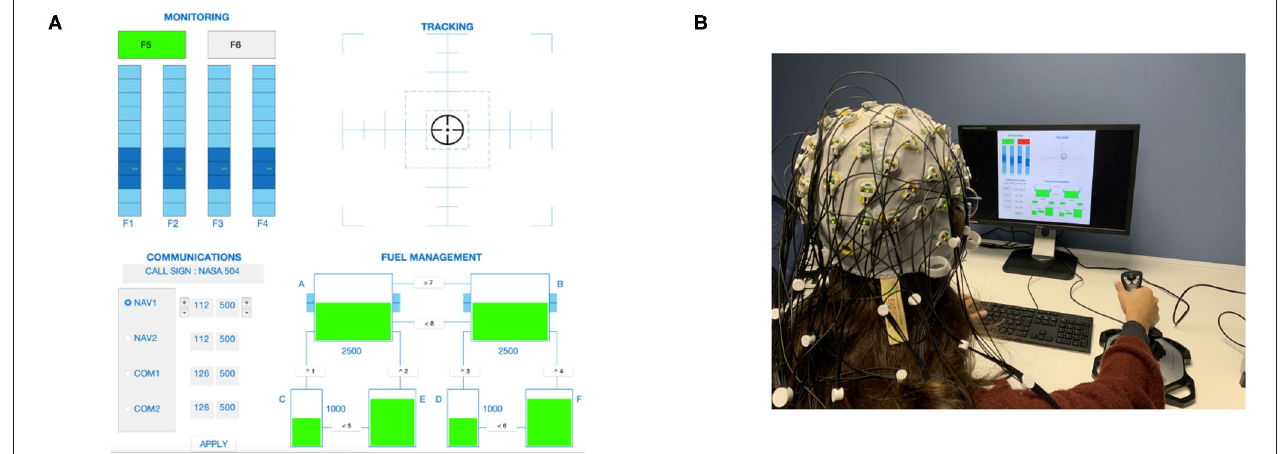
FIGURE 1 | Experimental setup. (A) Screenshot of the MATB-II task performed by the participants, with four sub-tasks: namely (from the top left corner to the bottom right corner) Monitoring, Tracking, Communications, and Fuel management. (B) Database acquisition experimental